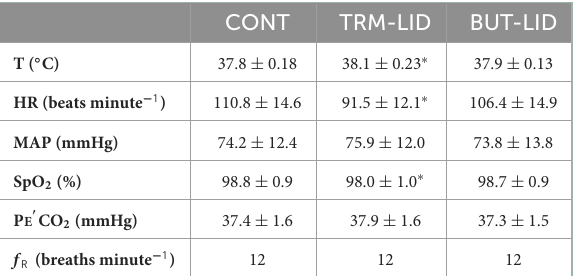
TABLE 2 Mean ± standard deviation of the cardiorespiratory variables in control (CONT), tramadol- lidocaine (TRM- LID), butrophanol-lidocaine (BUT-LID) treatments at MAC determination 2min before applying noxious stimulus obtained from 10 female dogs in each